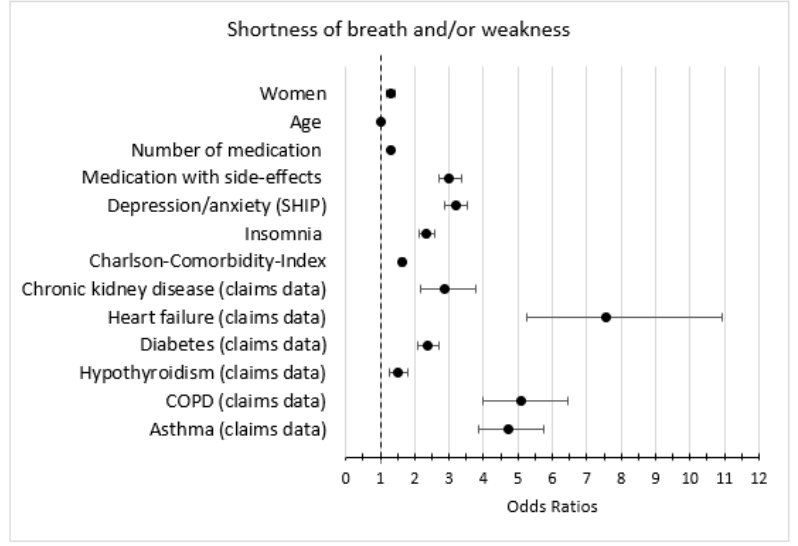
Figure 5. Bivariate logistic regression models (anemia + second variable) with the outcome lack of concentration; only the estimates (odds ratios and 95% confidence intervals) of the second variable is shown (weighted).